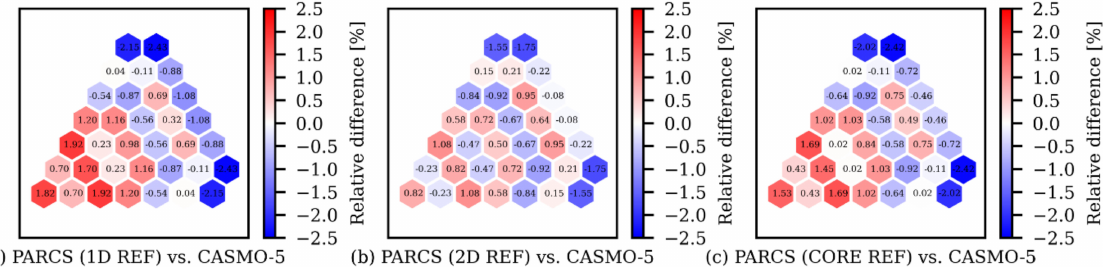
Figure 20. Radial power differences of PARCS with respect to CASMO-5 for different reflector models.